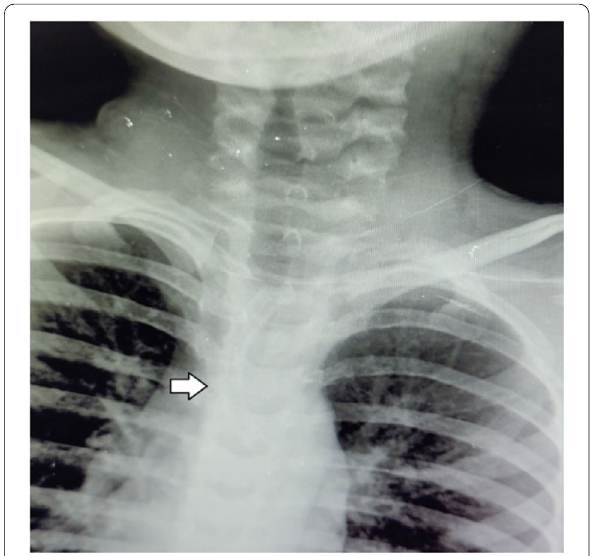
Fig. 1 Xray soft tissue neck-AP view arrow showing part of tracheostomy tube